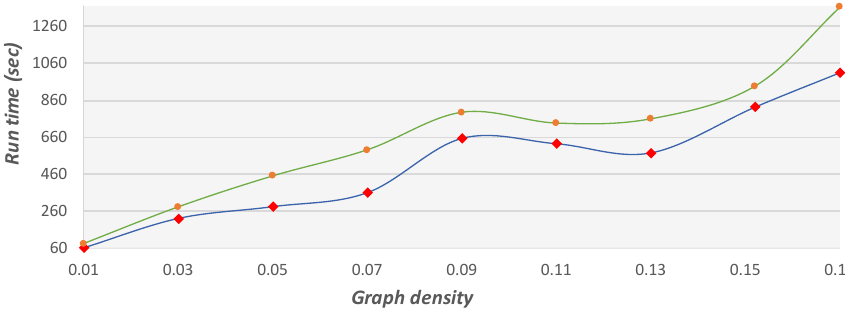
Figure 17. Run time comparison on graphs with 2000 vertices at different densities. This graph presents the run time of the 2-factor approximation method ( green ) and the GA ( blue